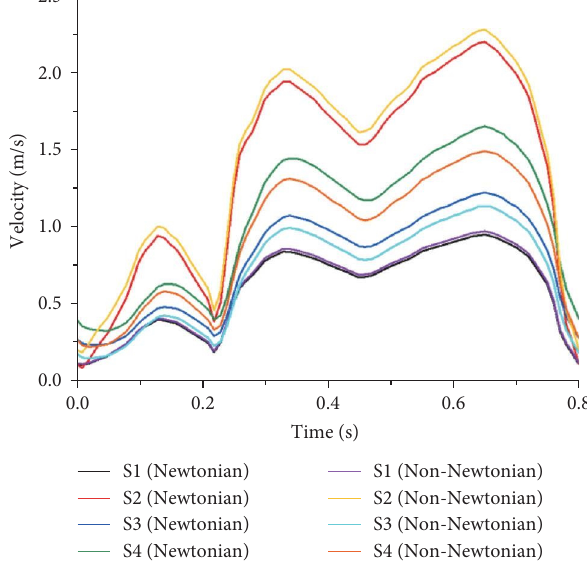
F IGURE 8: Maximum velocities on normal